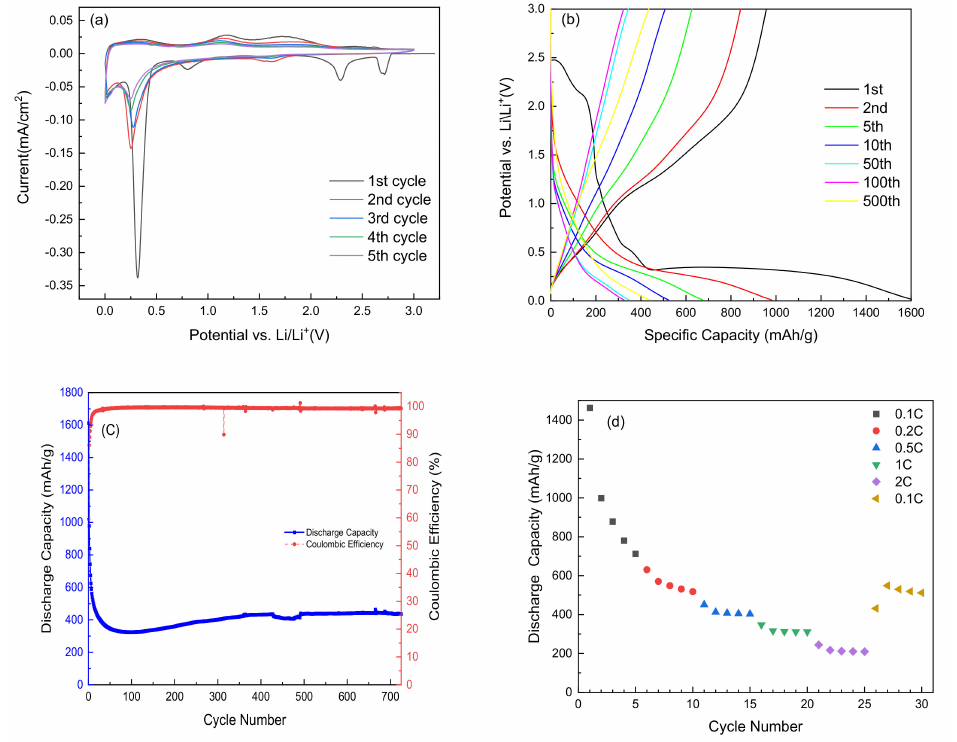
Figure 7. Electrochemical performance of MOA as anode material: ( a ) five first cyclic voltammograms recorded 0.01 mV s − 1 scanning rate, ( b ) galvanostatic charge/discharge curves carried out at 1C-rate (~1.1 A g − 1 ) in the potential window 0.01–3.0 V vs. Li + /Li, ( c ) specific discharge capacity and Coulombic efficiency as a function of cycle numbers performed at a 1C-rate, and ( d ) rate